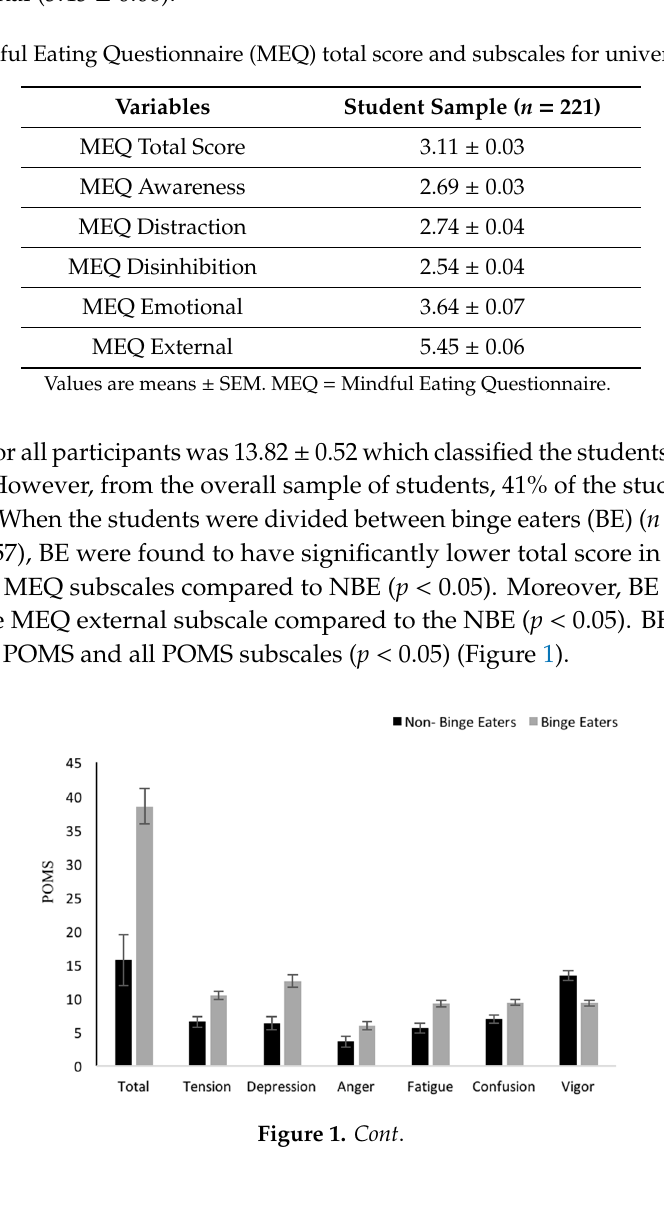
Table 2. Mindful Eating Questionnaire (MEQ) total score and subscales for university students.